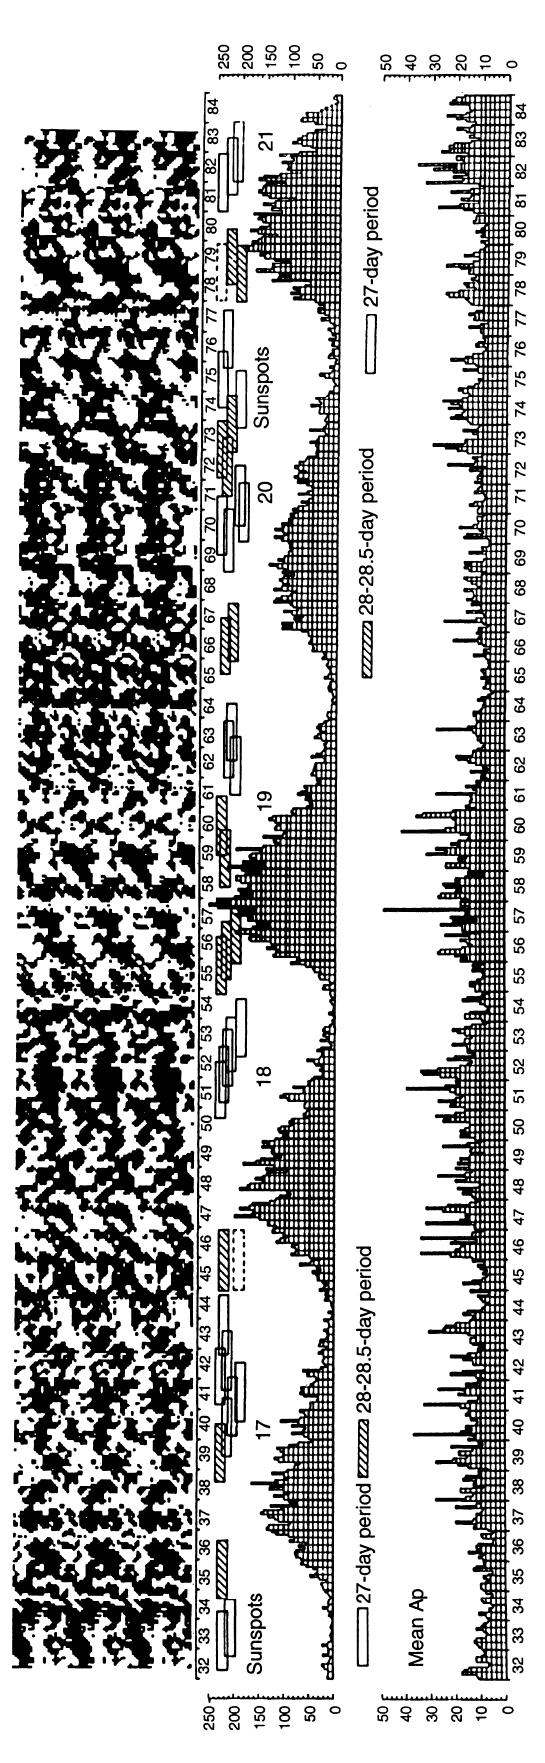
(cid:255) (cid:1) 2 a (cid:19) (cid:135) a (cid:19) n (cid:135) 1 , where a 0 n n (cid:255) 1 n